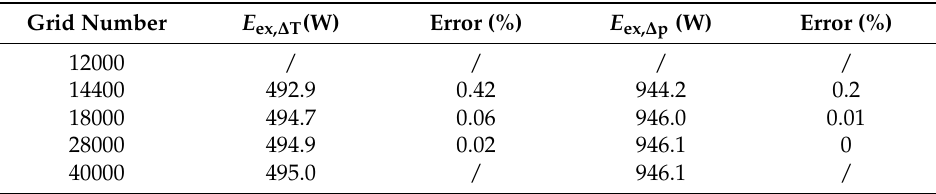
Table 2. Grid independence